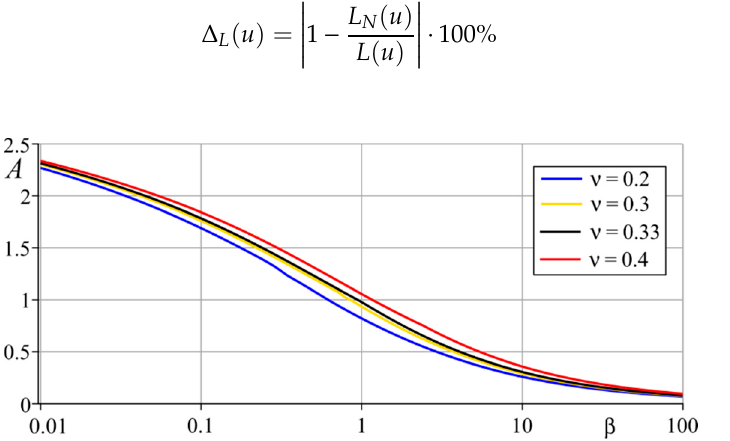
Figure 2. Dependence of a parameter A of the simplified approximation of the kernel transform on a relative Young’s modulus β for ν ( s ) = ν ( c ) .